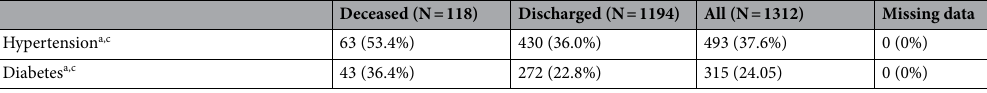
Table 2. Data summary of study cohort for Mortality. Data summary of patients used for predicting Mortality. For numeric variables the median is given along with the 0.25 and 0.75 quantiles. For categorical variables the count is given along with the percentage of the population. The fourth column represents the number of missing data and their proportion to the dataset.